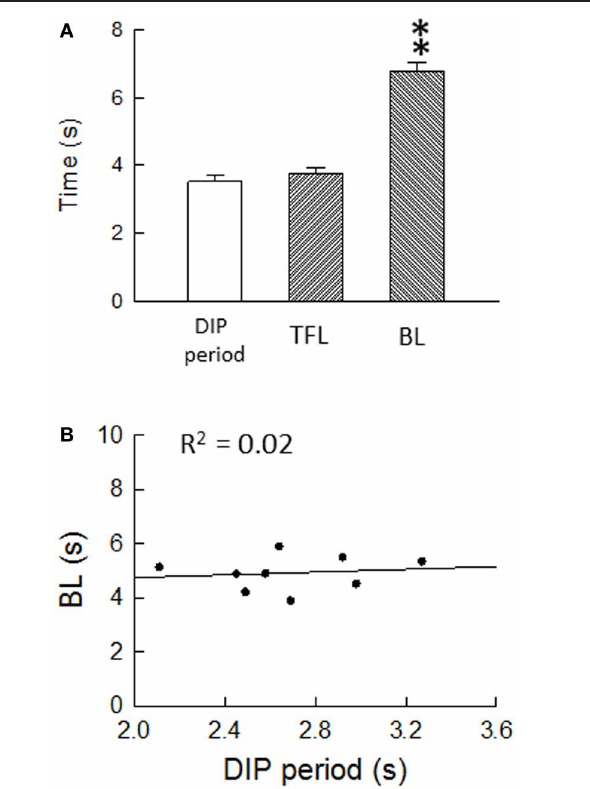
FIGURE 9 | The effect of either bilateral lesions of theLC/SC (A, n = 12) or sham lesions of the LC/SC (B, n = 10) on the tail flick latency. ∗∗ P < 0 . 01, significantly different from the tail flick latency of the non-air-puff condition. Pre, pre-lesions; Post, post-lesions. Note that a significant Air-puff stimulation-induced prolongation of the tail flick latency was not observed in post-lesions of the LC/SC-lesioned rats, whereas tail flick latencies were significantly prolonged by air-puff stimulation in pre-lesions, suggesting that the descending inhibitory system from the LC/SC is involved in air-puff stimulation-induced antinociception (Tsuruoka et al., 2011).